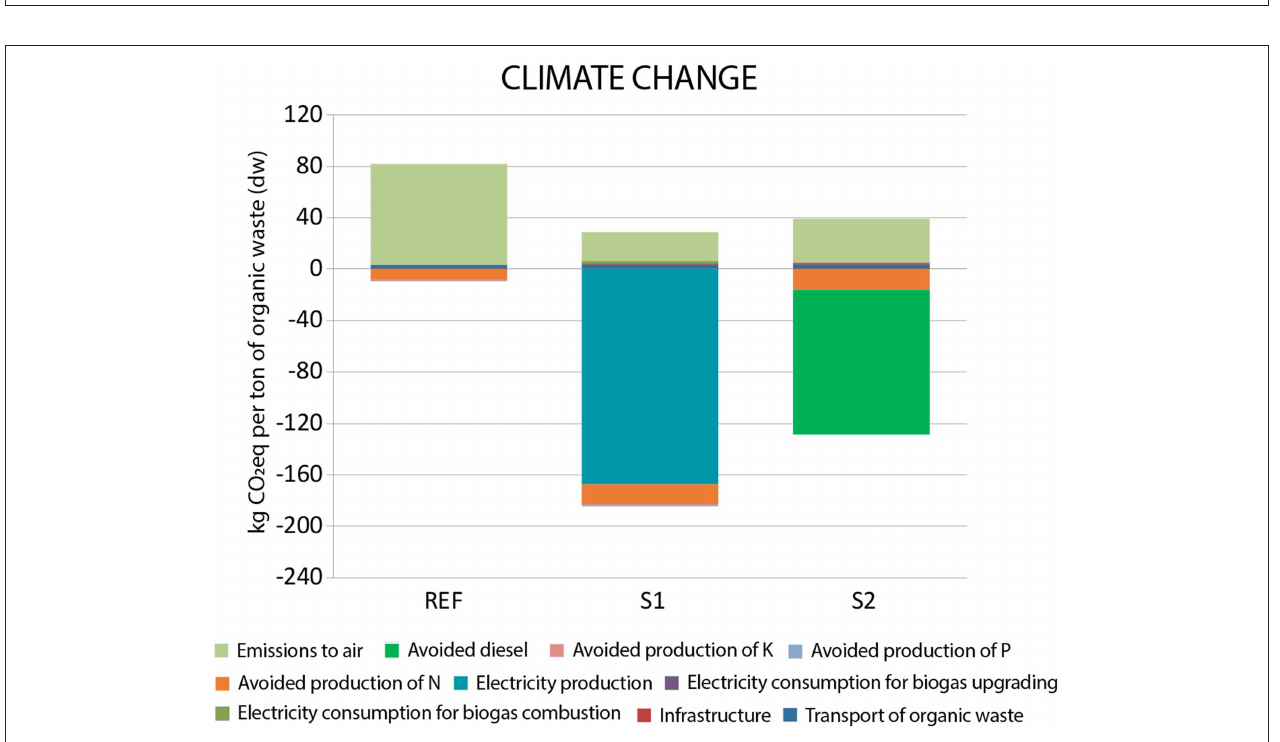
FIGURE 3 | Comparison of the reference and alternatives scenarios for the category of climate change. Results are displayed as equivalent kg of CO 2 per ton of dry weight organic